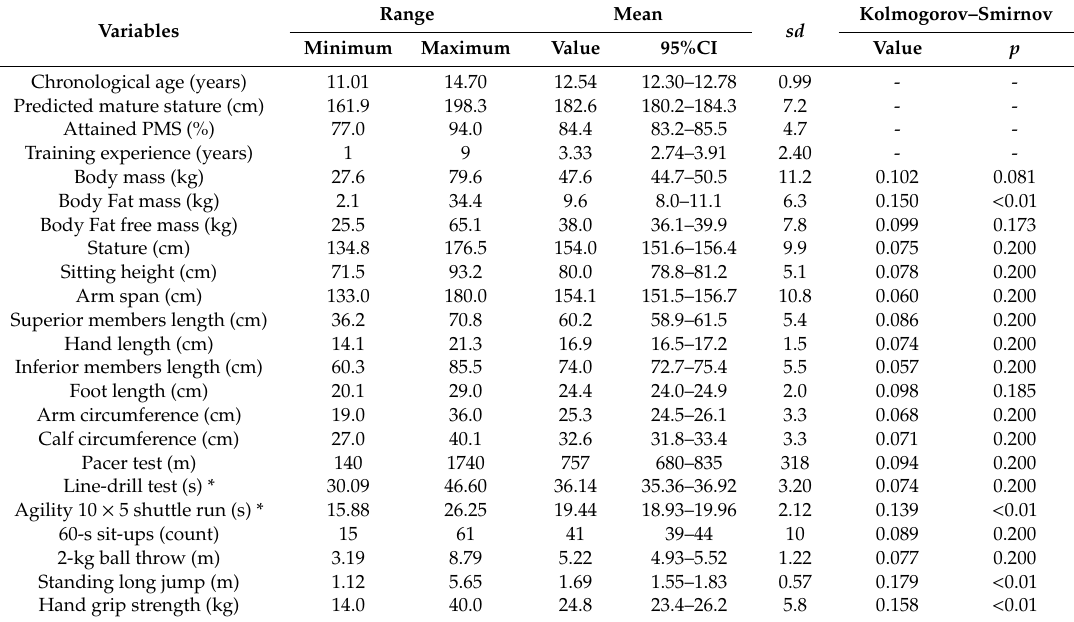
Table 1. Descriptive statistics for the total sample and test of normality ( n = 67).